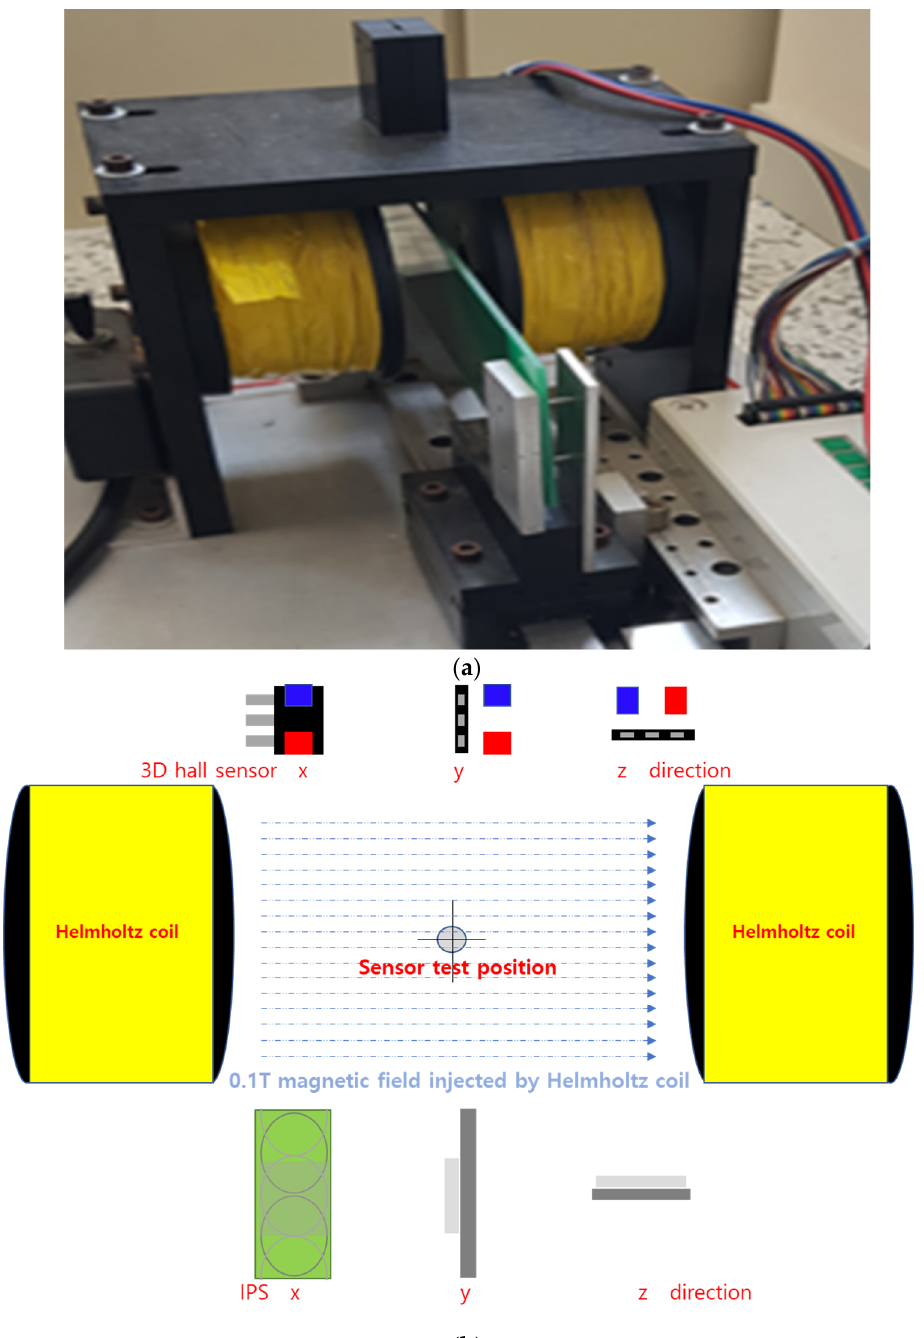
Figure 14. Experiment to determine the effect of a strong magnetic field (0.1 T) in x , y , or z directions on a 3D Hall sensor or inductive position sensor (IPS): ( a ) photograph of test setup; ( b ) schematic diagram.